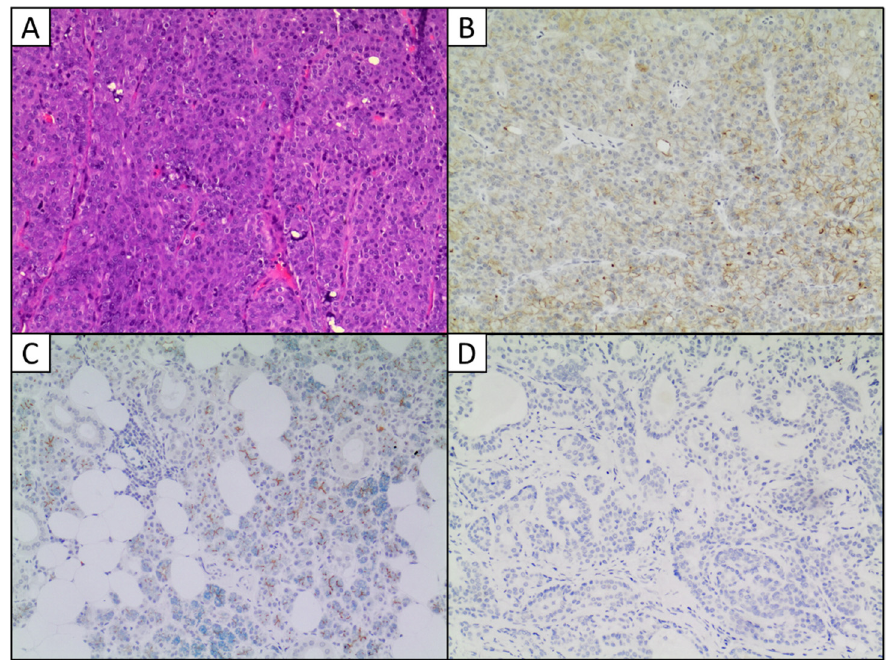
Figure 2. ( A ) Hematoxylin and eosin staining of a case of ACC from our institution (100×). ( B ) Immunohistochemistry showing DOG1 strong membranous expression with cytoplasmic reinforcement in one case of our series of ACCs (100×). ( C ) Immunohistochemistry showing DOG1 apical/luminal staining in normal salivary acini (100×). ( D ) Immunohistochemistry showing DOG1 negativity in a pleomorphic adenoma from our institution (100×).